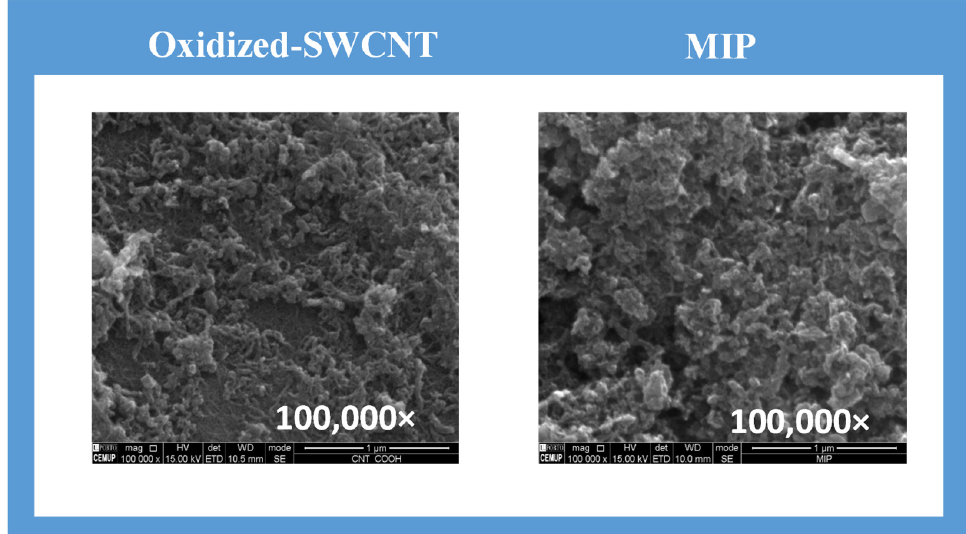
Figure 4. SEM images of oxidized SWCNT and MIP materials.